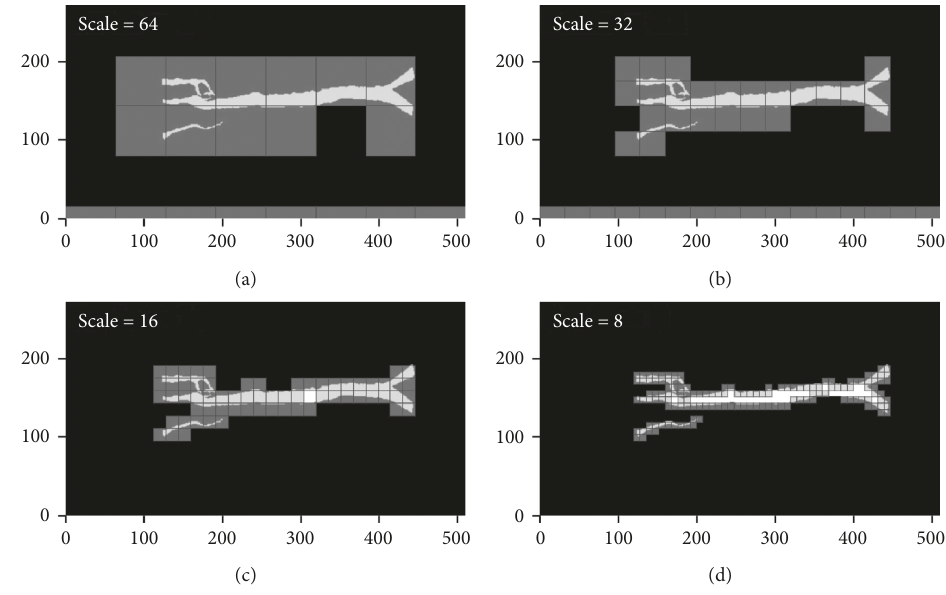
Figure 8: An illustration of different box scales to fully cover